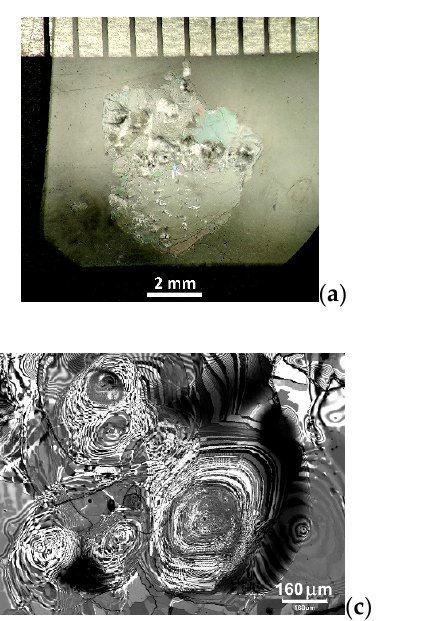
Figure 3. p-Quinquephenyl crystals grown by the PVT method: ( a , b ) photographic images of the crystals laminated on a glass substrate (( b )–under the UV light of 365 nm); ( c ) the confocal image (scanning mode) of the surface area with a number of dislocation growth hills; ( d ) the confocal image (scanning mode) of the apex of the multiturn dislocation